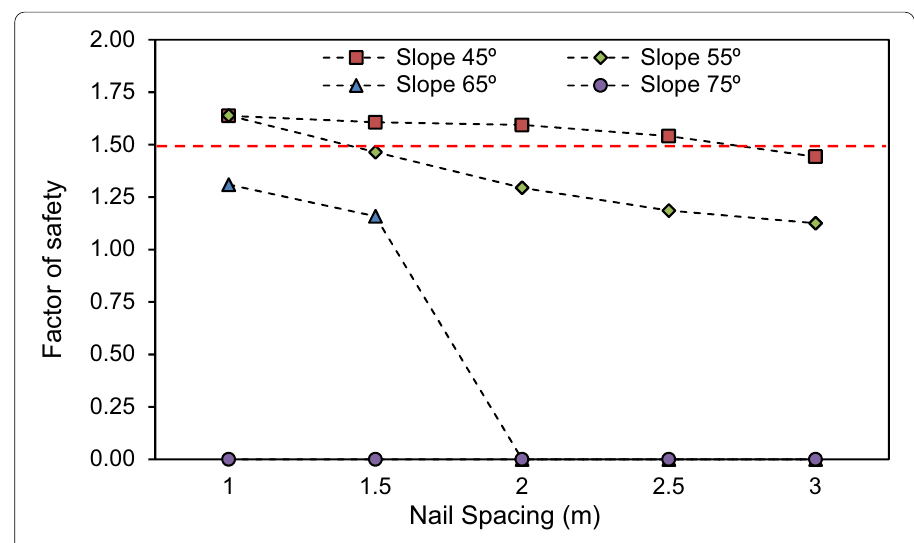
Fig. 4 The effect of nail spacing on four different slope